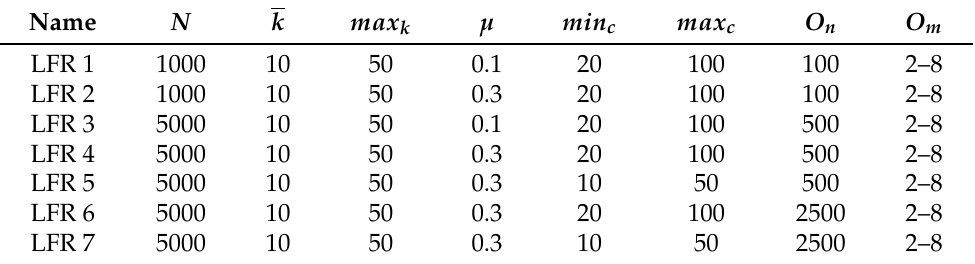
Table 1. The detailed parameters of LFR benchmarks are shown. LFR 1 to LFR 4 are grouped to test the performance of algorithms under different network sizes and mixing parameters, while LFR 4 to LFR 7 are governed by different community sizes and overlapping